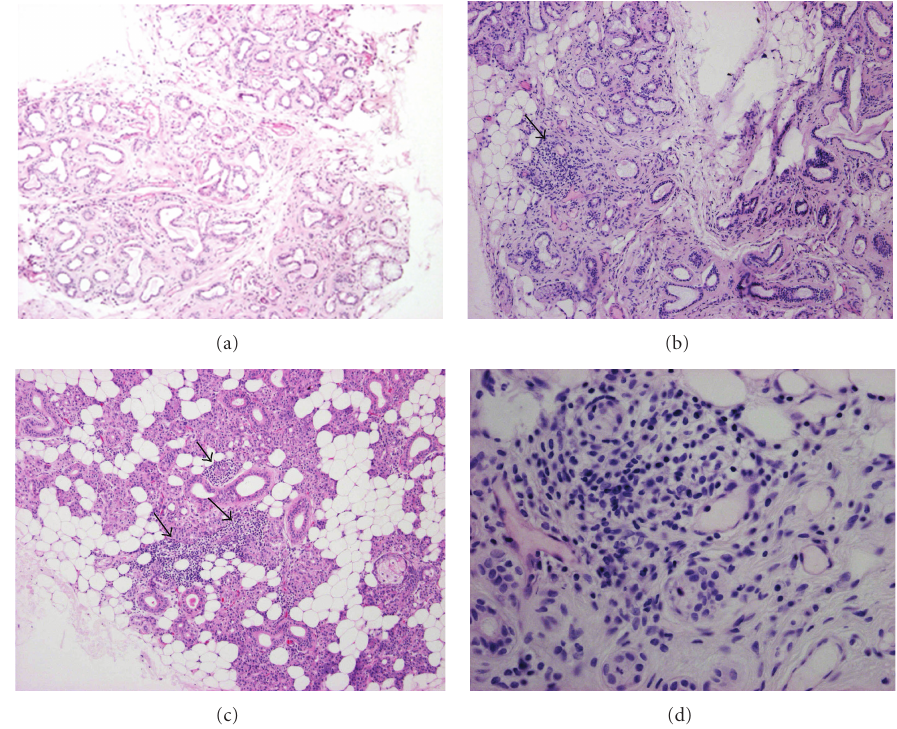
Figure 1: Histological analysis of salivary gland biopsies. Minor salivary glands ((a) first biopsy; (b) second biopsy) and parotid gland (c) biopsies were stained using hematoxylin-eosin. Original magnification: 100x. Arrows are pointing to lymphocytic infiltrates. (d) shows higher magnification (400X) of parotid gland biopsy depicting lymphocytic